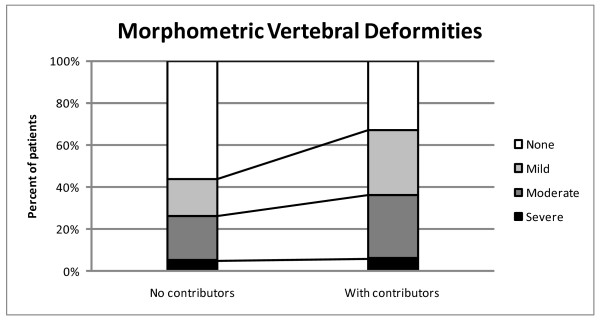
Prevalence of MVD defined according to the grading of Genant et al. in patients with contributors to secondary osteoporosis and in patients without contributors.